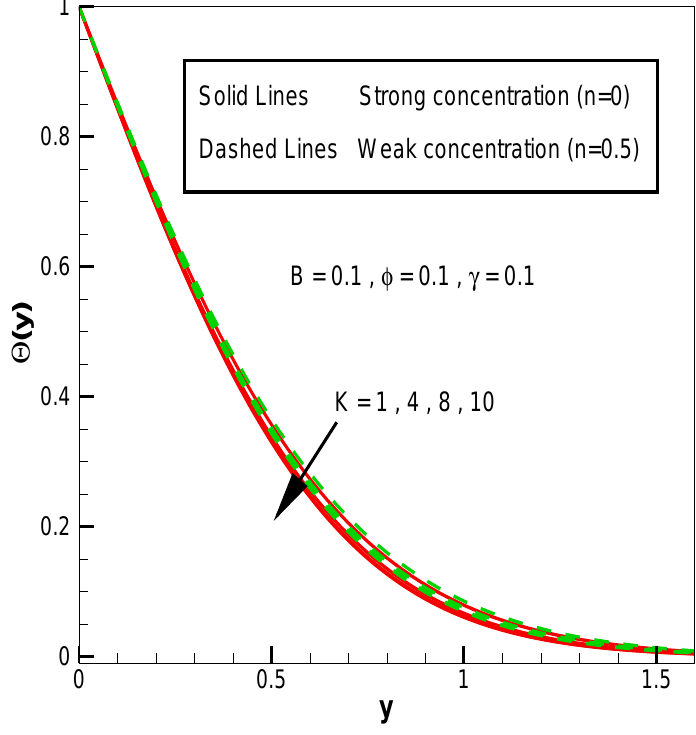
Figure 6. θ ( y ) for material parameter K Figure 6. 𝛉(𝐲) for material parameter 𝐊 .